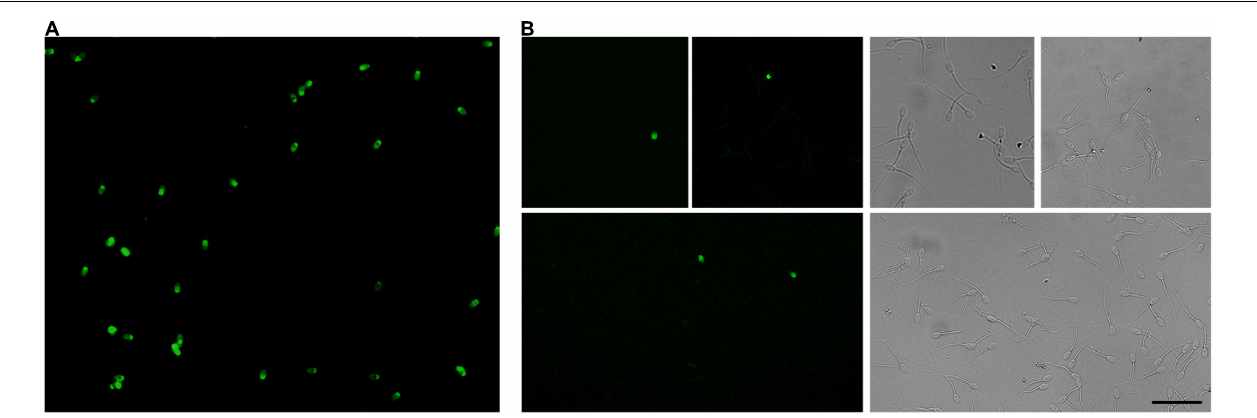
FIGURE 5 | Apoptosis associated DNA fragmentation in cryopreserved ram sperm. DNA breaks in thawed spermatozoa were labeled using the terminal deoxynucleotidyl transferase-mediated dUTP nick-end labeling reaction (TUNEL). TUNEL-positive ram spermatozoa show green fluorescence in the head. (A) Positive control achieved by DNase I treatment with all spermatozoa showing green fluorescence. (B) Representative TUNEL-positive sperm from experimental groups on the left panels and respective bright fields on the right. Scale bar represents 40 µ m.